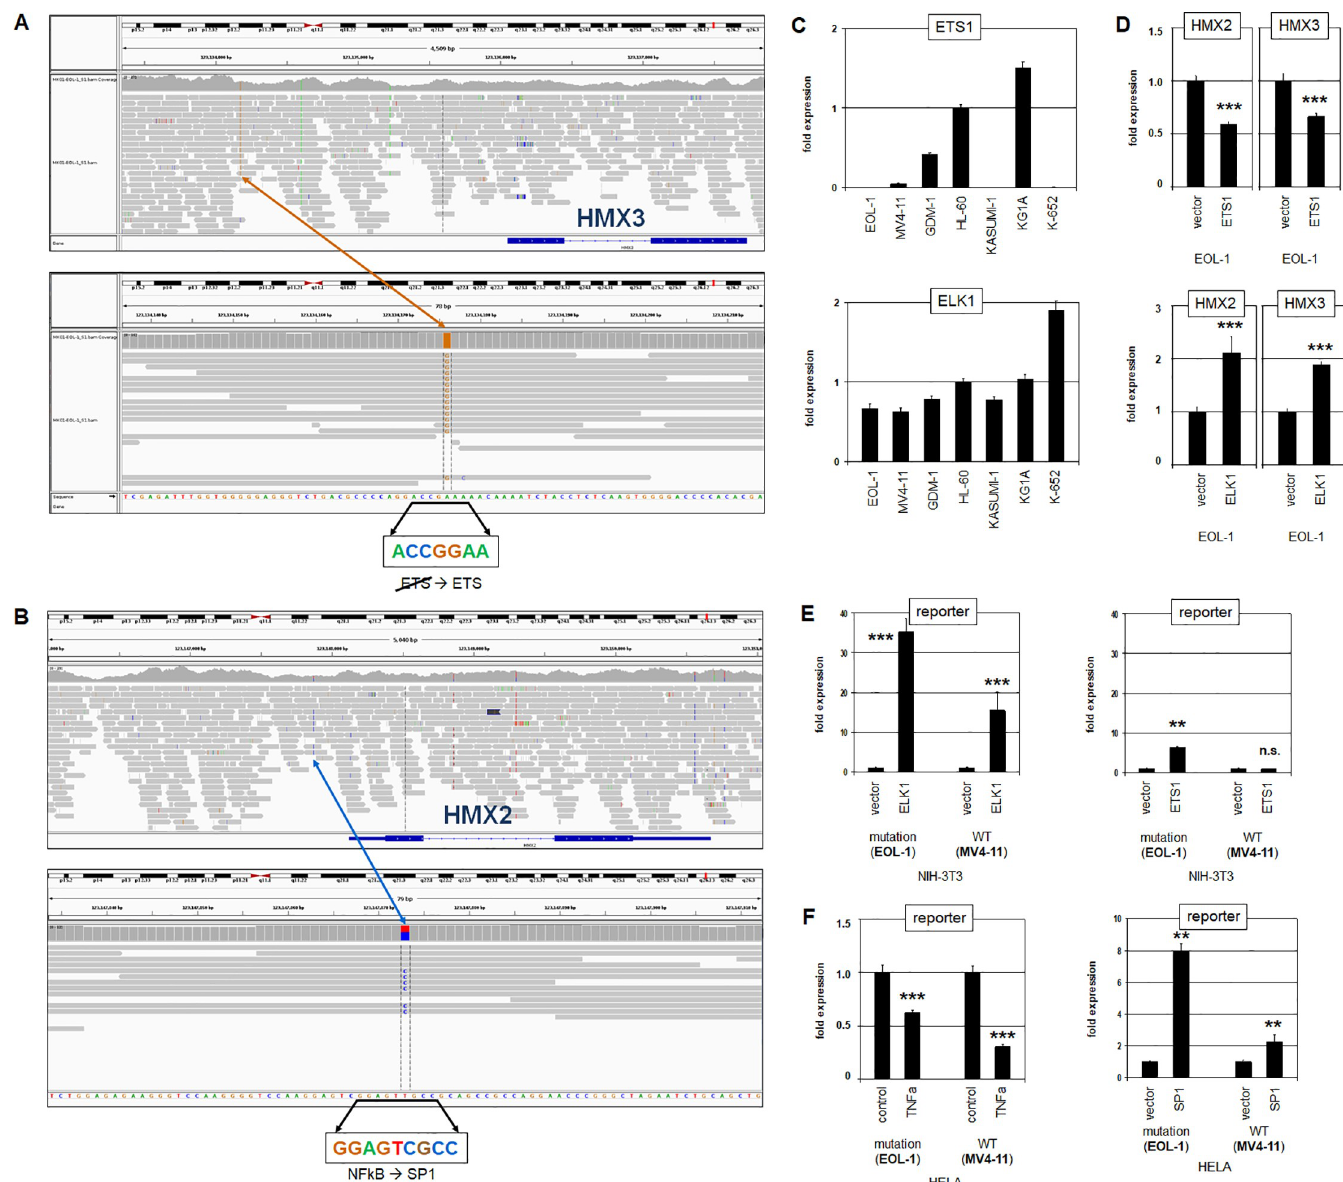
Fig 4. Regulatory mutations at HMX2/3 in EOL-1. The illustration of RNA-seq data from EOL-1 shows two different mutations at the HMX2/3 locus. (A) An A-to-G mutation in the 5´-region of HMX3 generates a consensus ETS-site. (B) A T-to-C mutation in the 5´-region of HMX2 transforms an NFkB-site into a SP1-site. (C) Quantification of ETS1 (above) and ELK1 (below) in selected AML cell lines by RQ-PCR. (D) Forced expression of ETS1 (above) and ELK1 (below) in EOL-1 cells resulted in respectively reduced and increased expression levels of both HMX2 and HMX3. Asterisks indicate calculated p-values obtained by t-Test analysis of controls (vector) and factor expression. (E) Reporter-gene assay in NIH-3T3 cells using a fragment containing a normal (obtained from MV4-11) or mutated (obtained from EOL-1) ETS-site. Forced expression of ELK1 (left) and ETS1 (right) resulted in elevated reporter-gene activity which was higher using ELK1 for the mutated fragment. (F) Reporter-gene assay in HELA cells using a fragment containing a normal (MV4-11) or mutated (EOL-1) NFkB-site. Treatment with NFkB-activator TNFa (left) resulted in reduced reporter-gene activity which was more pronounced using the normal fragment. Forced expression of SP1 (right) resulted in elevated reporter-gene activity which was higher using the mutated